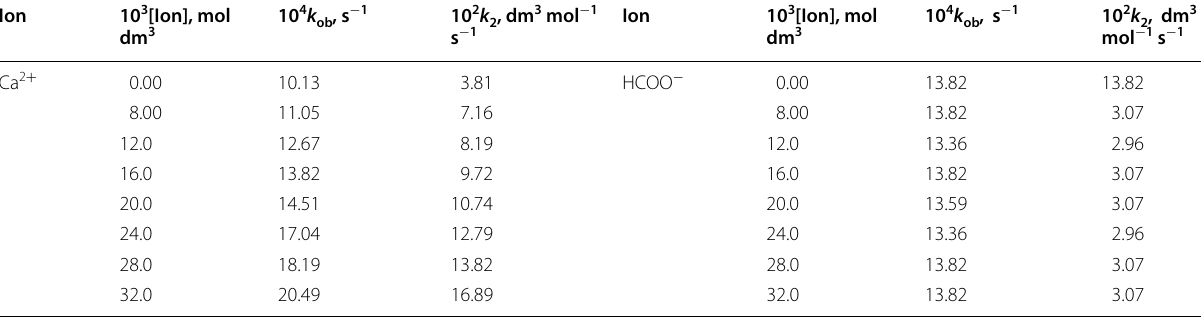
Table 3 Effect of counter-ions on the rate constants for the reaction of and ATH